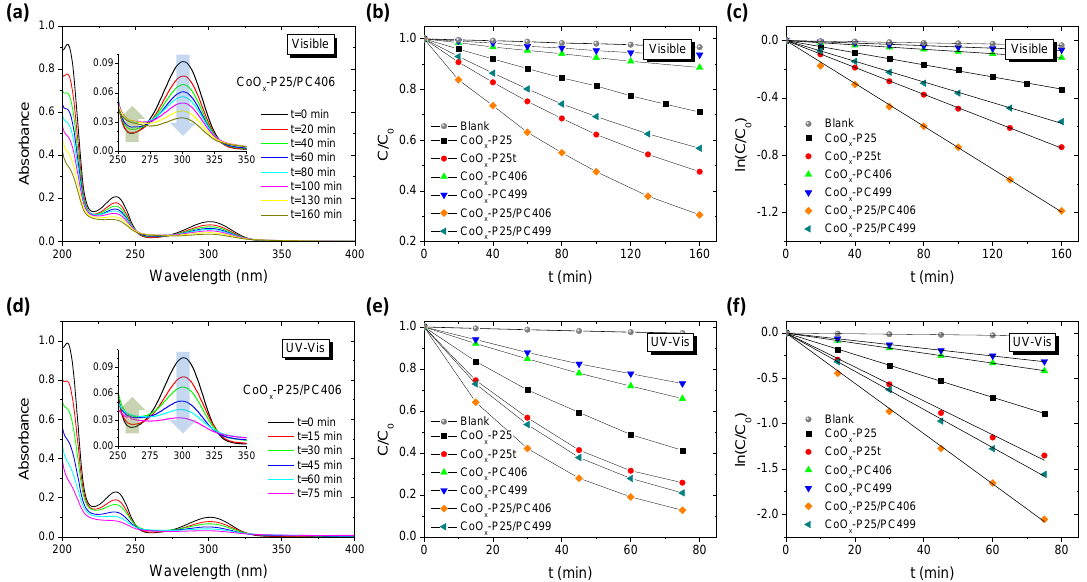
Figure 6. Temporal salicylic acid (SA) absorbance evolution for CoO x -P25/PC406 and SA photodegradation kinetics for the monolithic and bilayer CoO x -TiO 2 films under ( a – c ) visible and ( d – f ) ultraviolet (UV)–visible light (Vis) irradiation. The downward and upward arrows in ( a ) and ( d ) depict the SA decomposition and intermediate product generation, respectively.